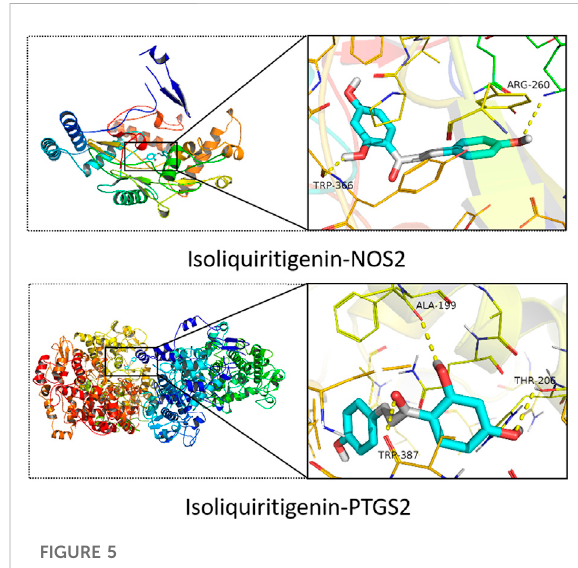
FIGURE 5 Molecular docking of ISL with PTGS2 and